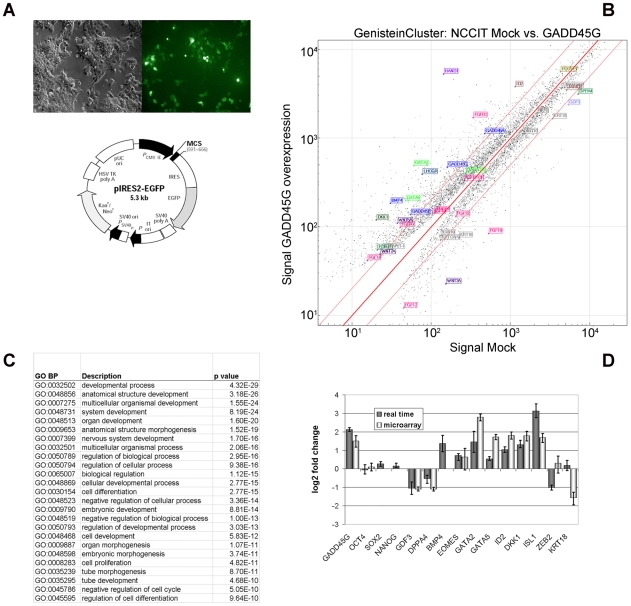
Over-expressing GADD45G in NCCIT cells.A: Presence of GFP expression 48 h post-transfection (left) compared to the phase-contrast image of the cells. The map of the vector used is presented below. B: Scatter plot comparing the transcriptomes of GADD45G transfected cells against cells transfected with the wild-type vector. GADD45G-mediated induction of transcription factors such as HAND1 (purple), GATA4 (green), and ID2 (brown) depicted in boxes. C: Table listing the most significant GO:biological processes related to the up-regulated (>2-fold) genes. D: Real time PCR validation of a selection target genes (NANOG, SOX2 and BMP4 were below detection score 0.01).